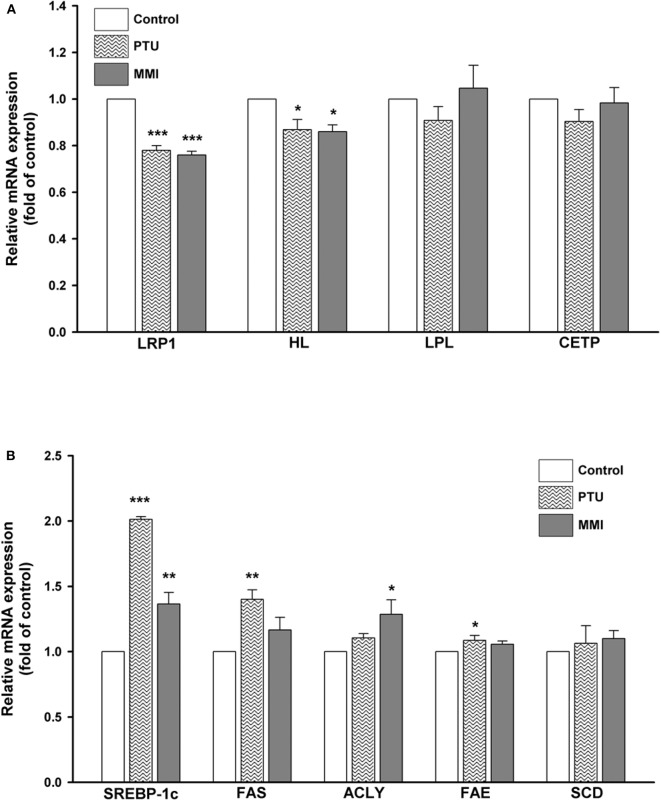
Expressions of hepatic lipid metabolism-related genes following treatment with 6-n-propyl-2-thiouracil (PTU), and methimazole (MMI). Differentiated HepaRG cells were treated for 24 h with PTU (31 μM) or MMI (3.42 μM). Following treatments, mRNA was extracted and the expression levels of (A)
LRP1, HL, LPL, CETP, and β-actin
(B)
SREBP-1c, FAS, ACLY, FAE, SCD, and β-actin were analyzed by qRT-PCR. Values were normalized to the expression of β-actin, with the levels of DMSO-treated cells set at 1. Results are expressed as means ± SD (n = 3), *P < 0.05; **P < 0.01; and ***P < 0.001 compared with cells treated with DMSO.